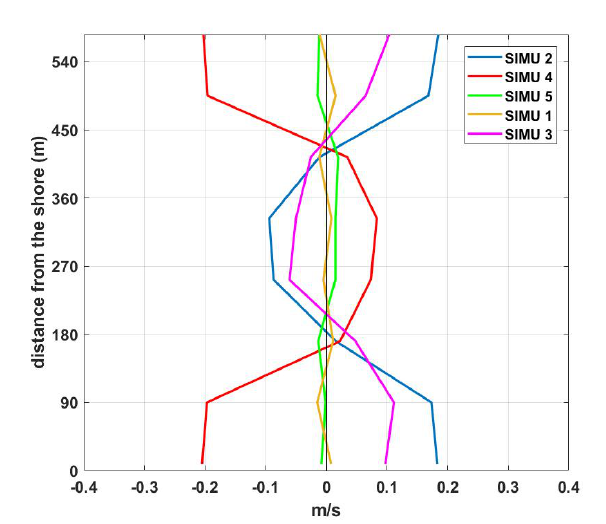
Figure 12. Barotropic velocities (negative outflow) in the entrance section for selected simulations.